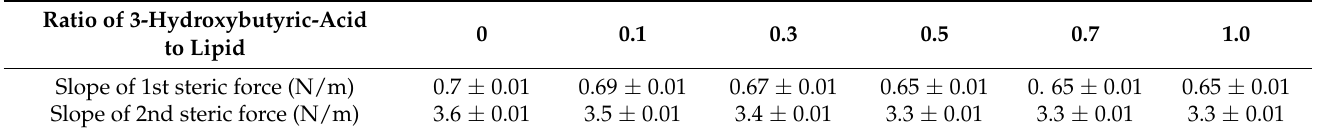
Table 1. Slopes of the force to the distance for the ratio of 3-hydroxybutyric acid to lipid. Ratio of 3-Hydroxybutyric-Acid to Lipid